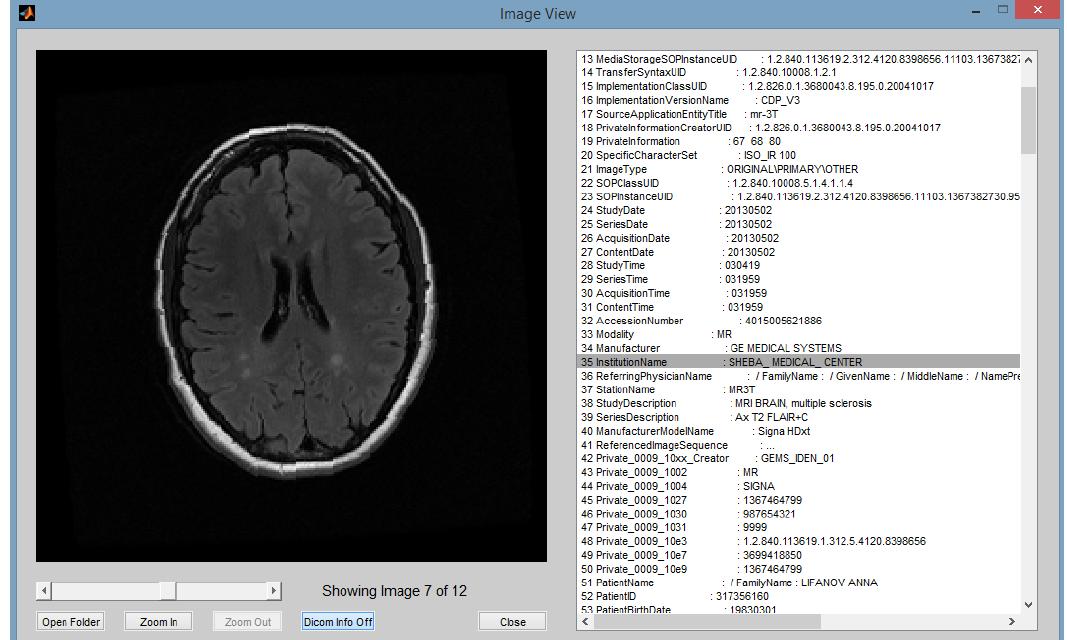
Figure 9. Graphical user interface for MS detection.